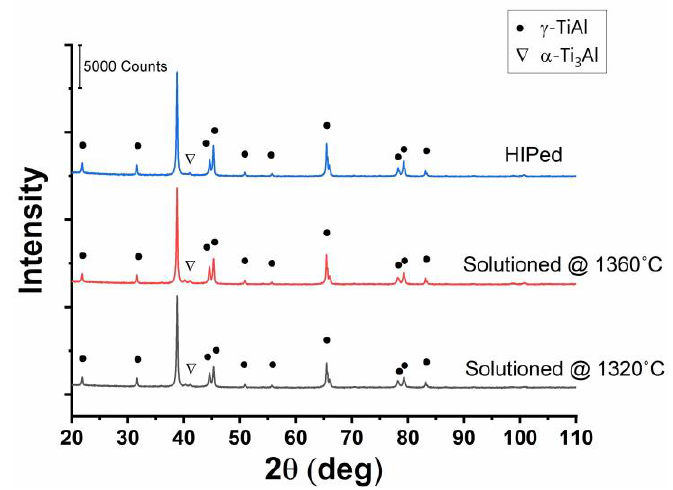
Figure 10. XRD patterns of the samples heat-treated under different conditions (samples were cut along the building